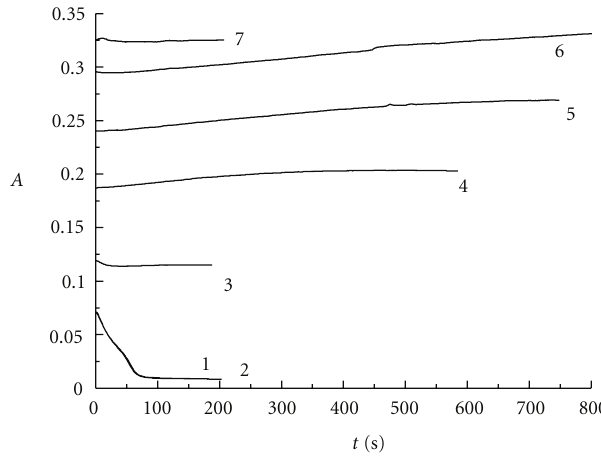
Figure 7: The absorbance versus reaction time for ClO 2 -KI system at 460 nm: curve 1: r = 0 . 26; curve 2: r = 0 . 53; curve 3: r = 0 . 79; curve 4: r = 0 . 99; curve 5: r = 1 . 97; curve 6: r = 2 . 96. When the mole ratio r is below or equal to